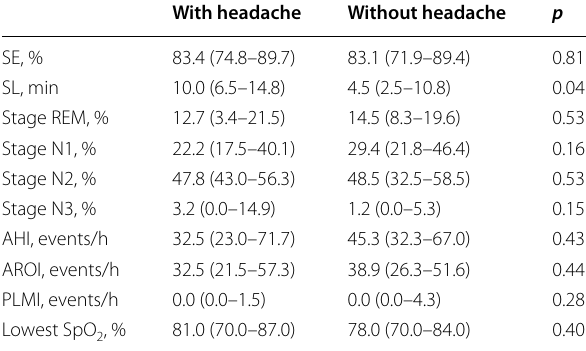
Table 2 Polysomnography parameters in sleep apnea